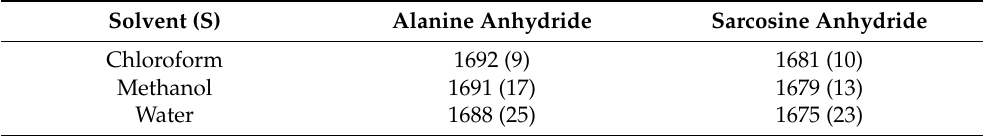
Table 2. Calculated absorption frequency of C=O group of anhydrides in proton donor solvents. Solvent